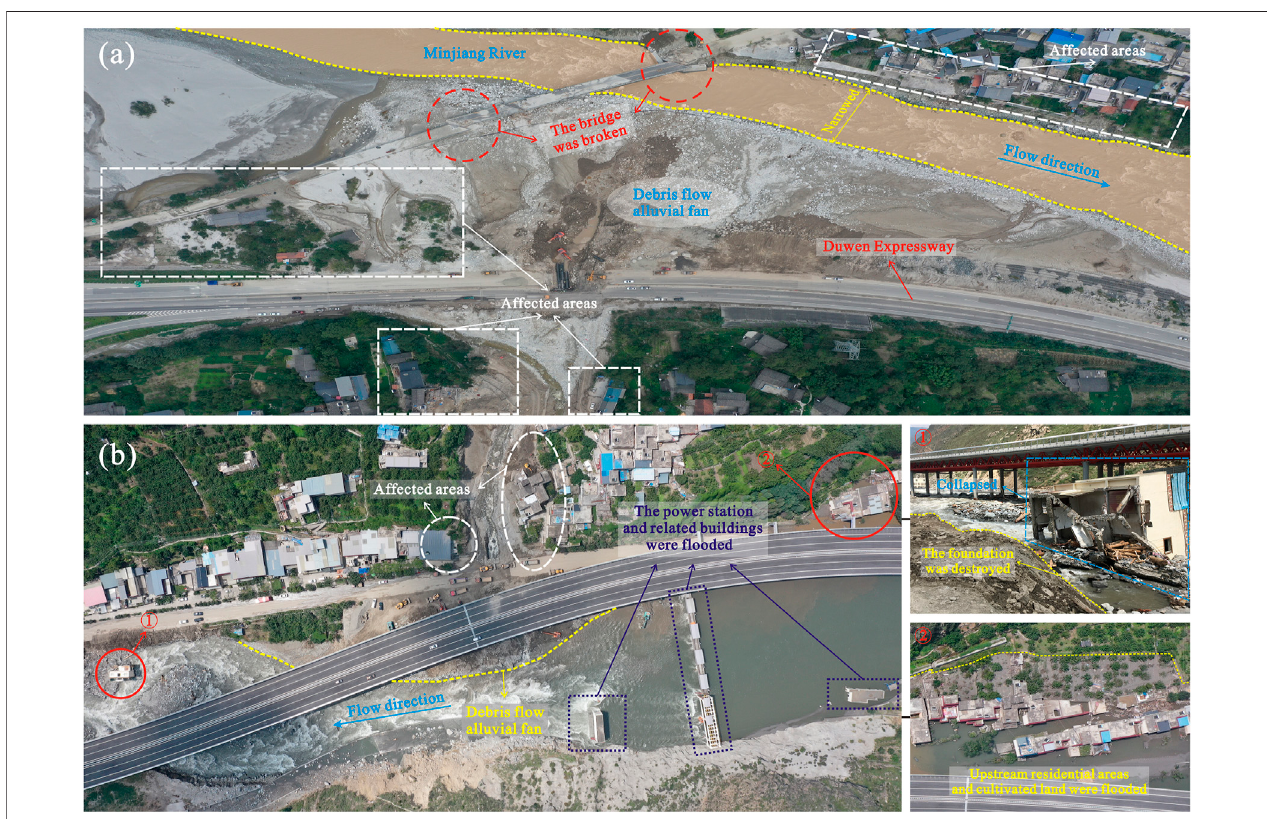
FIGURE 8 | Extrusion of the channel caused by the alluvial fan from the debris fl ow and the typical disaster characteristics: (A) blockage of the Minjiang River and long-distanceabnormalscouringtotheoppositebankcausedbythealluvialfanatthemouthoftheCutouGully;and (B) severe fl ooddisastercausedbythealluvialfanat the mouth of the Chayuan